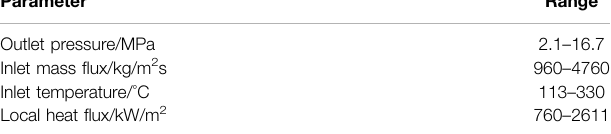
TABLE 2 | Parameter range of CHF experimental data.